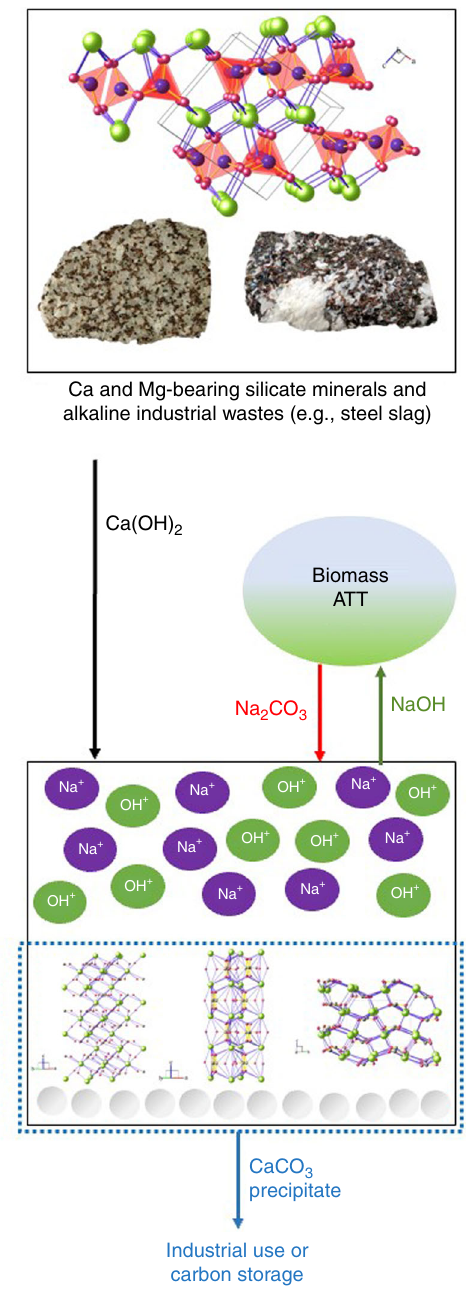
Fig. 5 Regeneration of NaOH via metathesis reaction using Ca(OH) 2 derived from minerals and alkaline industrial wastes. The ATT reaction produces high-purity H 2 while fi xing the seaweed carbon into solid carbonates (Na 2 CO 3 ). The dry solid residue containing Na 2 CO 3 can be regenerated on-site or easily transported to a centralized location for hydroxide regeneration. Ca(OH) 2 from silicate minerals and alkaline industry wastes such as steel slag can be used to regenerate NaOH via a metathesis reaction. The regenerated NaOH is used for the subsequent ATT reaction cycle and the produced CaCO 3 can be used as an industry product or stored to achieve the overall carbon negativity of the seaweed conversion